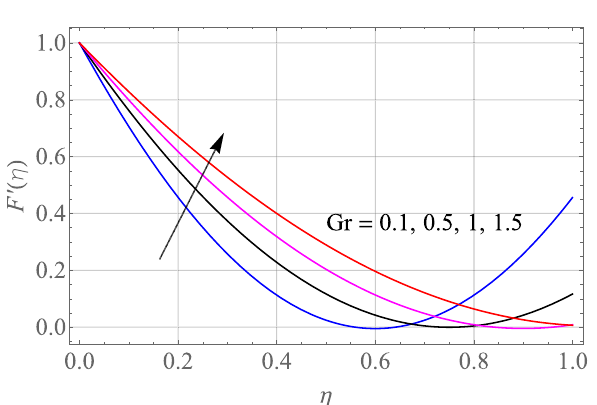
Figure 5. Alterations in F ′ (η) as Gr raises. When M = S = 0.1, Pr = 6.2, Gc = 0.2, Ec = 1, Nb = Nt = 0.3, Sc = 0.3